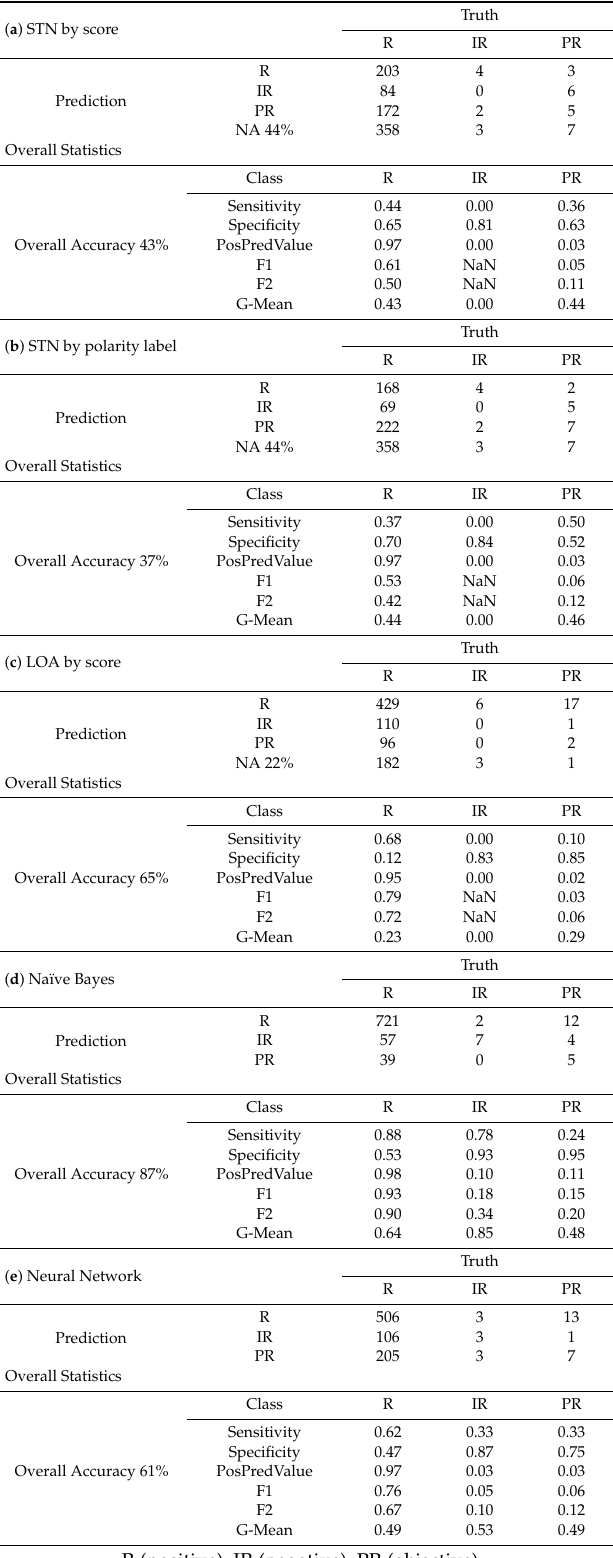
Table 3. The confusion matrices of fine-grained filtering processes over the Besiktas Vodafone Arena (BVA)